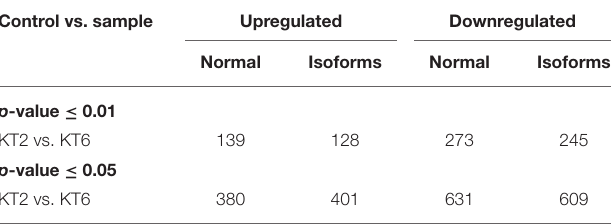
TABLE 2 | Total up- and downregulated genes along with isoforms (at p -value ≤ 0.01 and 0.05; FPKM ≥ 1) obtained using cuffdiff analysis. Control vs.